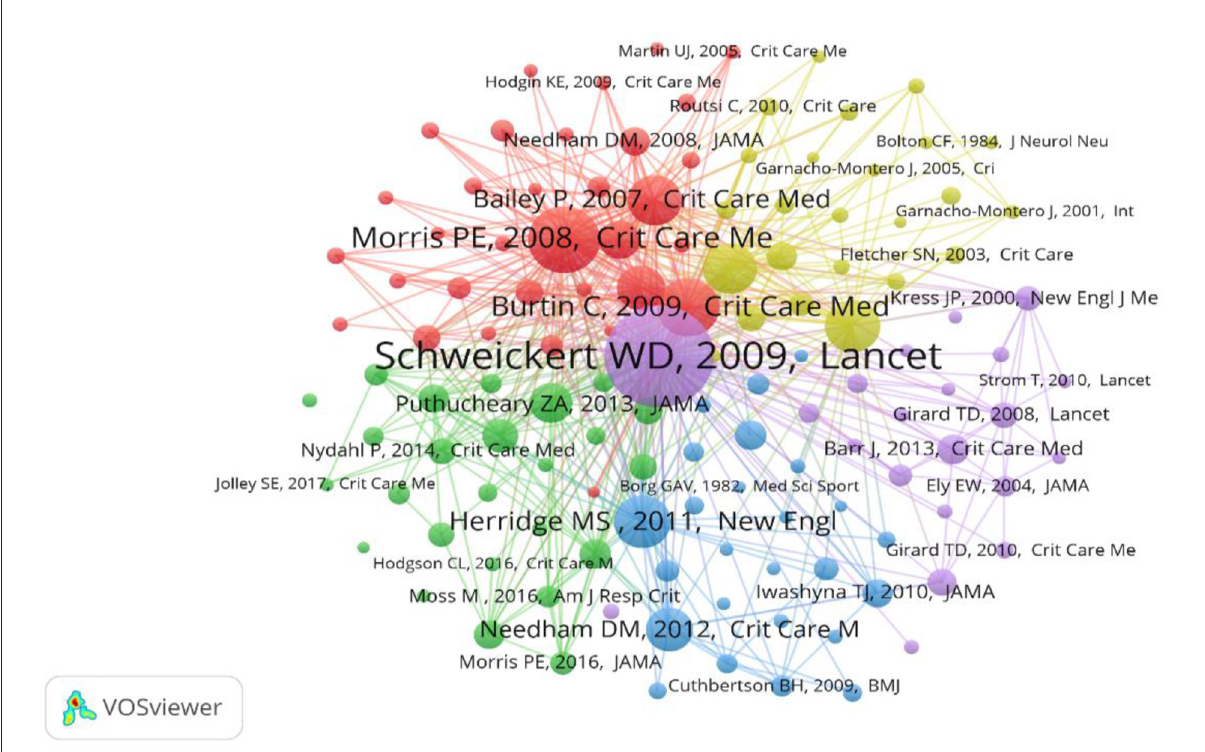
FIGURE5 Network map of co-citation analysis of references with more than 50